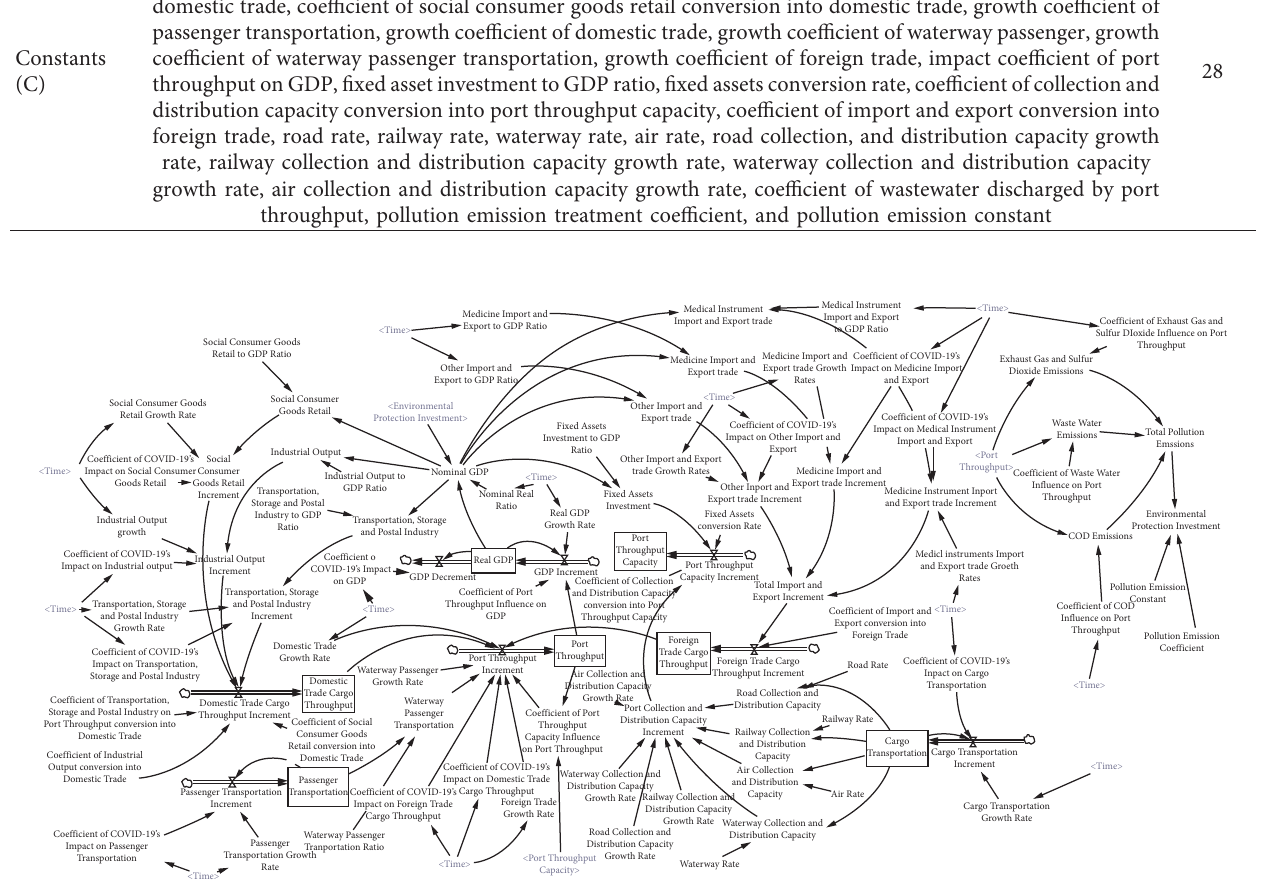
Figure 3: Flow diagram of port production and